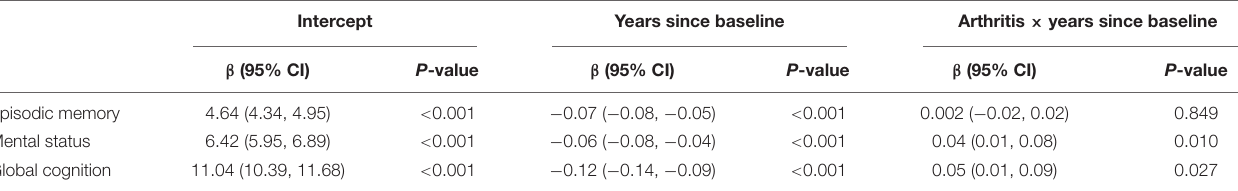
TABLE 4 | Changes of cognitive functions by baseline